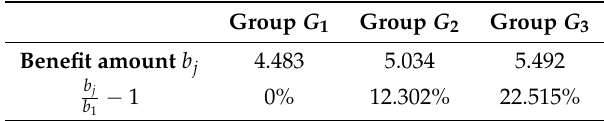
Table 7. Individual benefit amount for the three risk